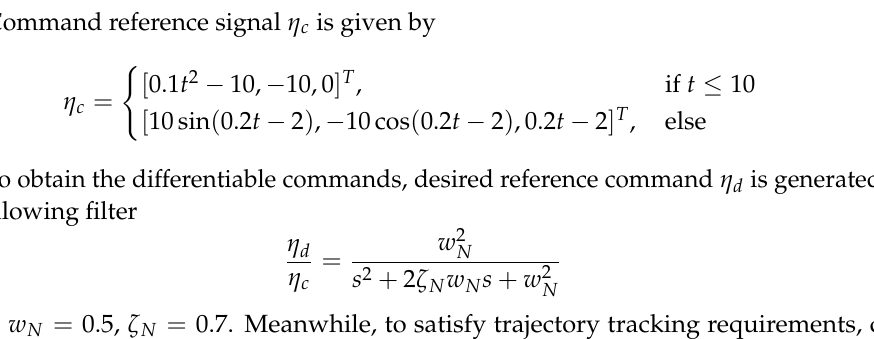
Figure 4. Disturbance estimation and double-layer adaptive switching gain (step